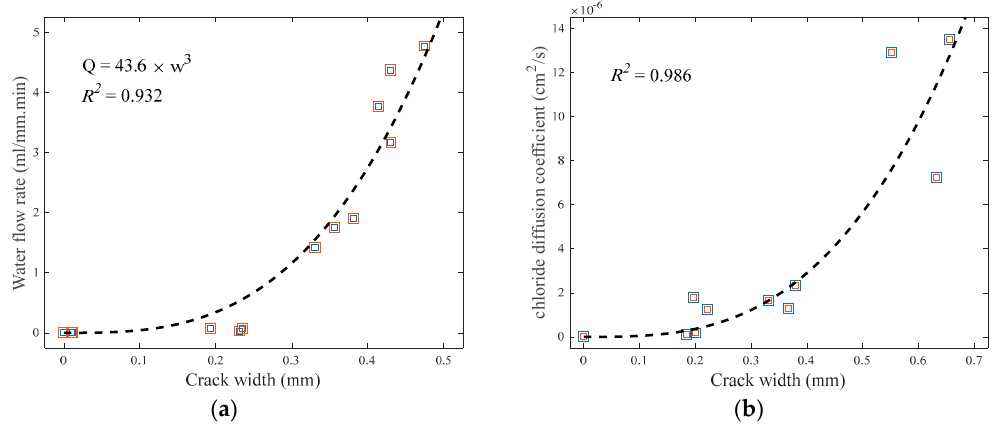
Figure 9. Change of ( a ) water flow rate and ( b ) chloride diffusion coefficient with respect to average crack width.